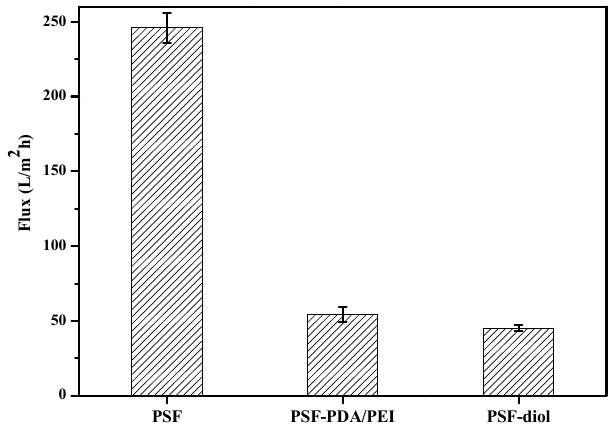
Figure 9. The flux of PSF, PSF-PDA / PEI, and PSF-diol membranes.